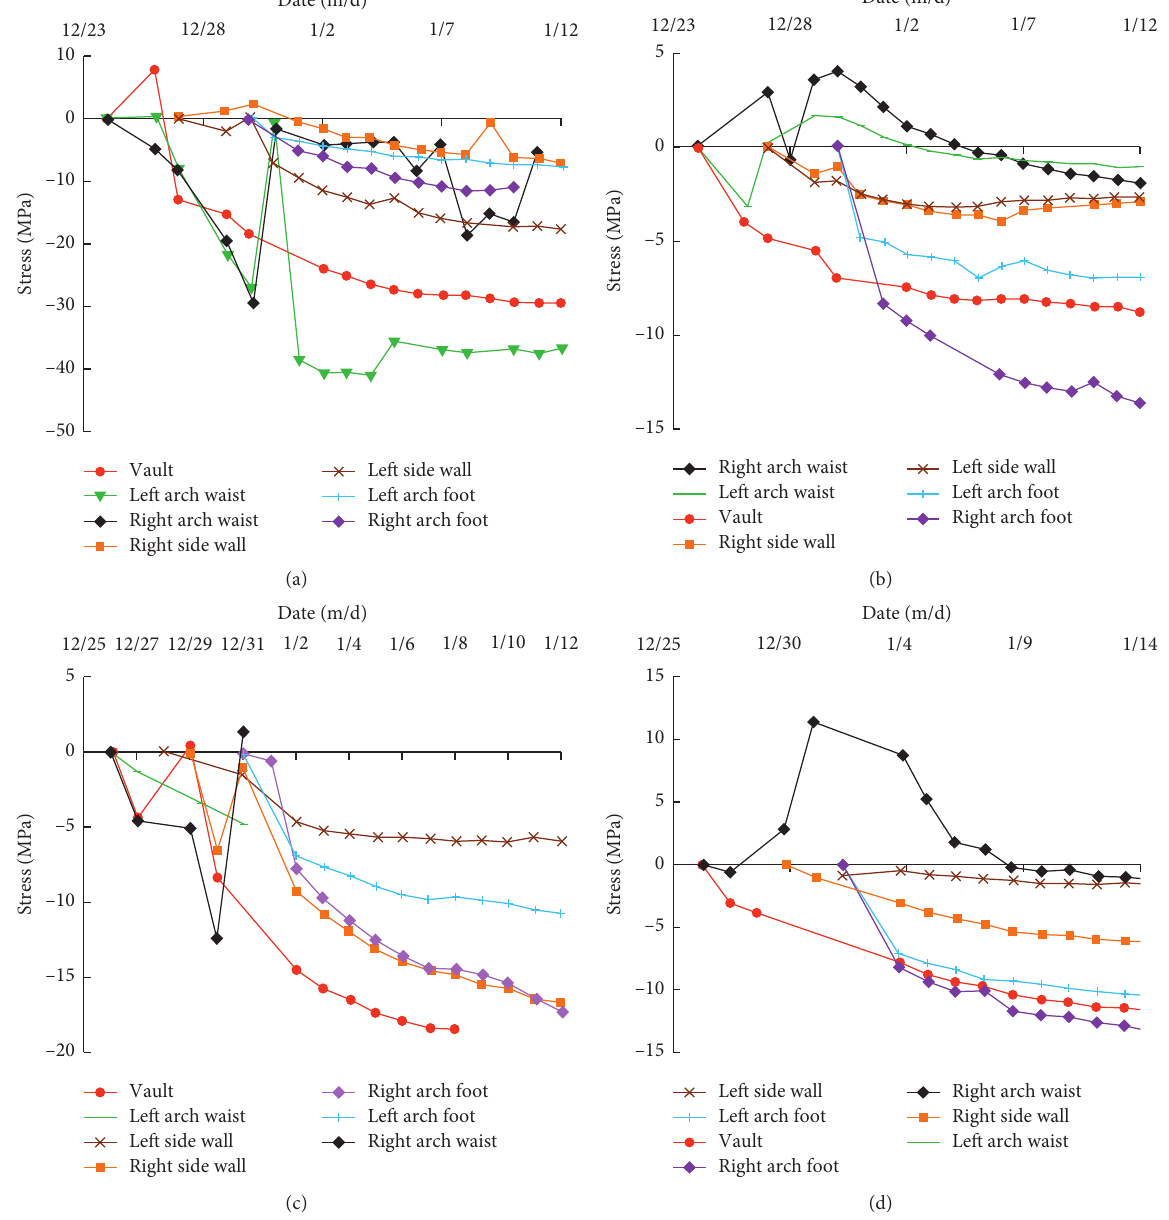
Figure 16: Time-history curves of concrete stress. (a) DK390+163 inside. (b) DK390 +163 outside. (c) DK390 +159 inside. (d) DK390 +159